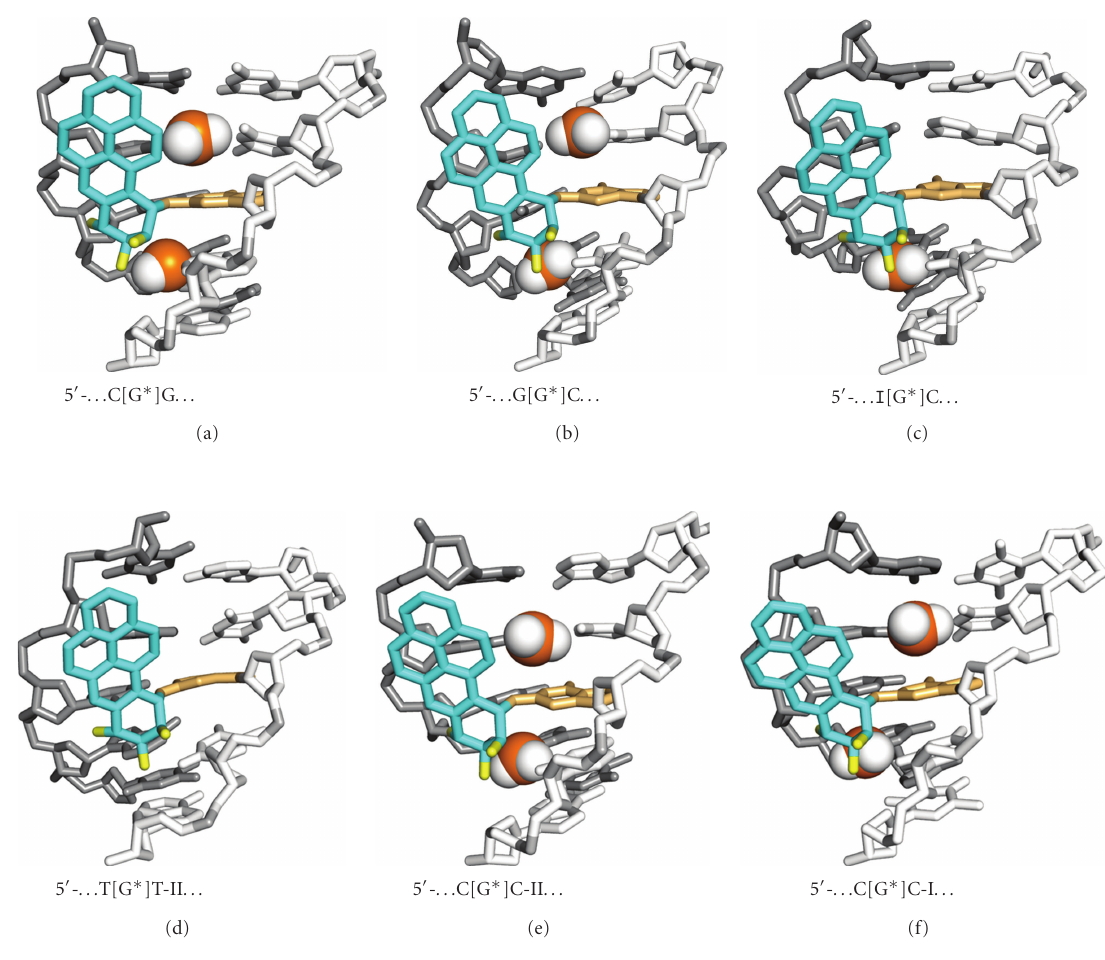
Figure 2: E ff ects of nearby guanine amino groups on the positioning of the 10 S (+)- trans - anti -B[ a ]P- N 2 -dG adduct in the minor groove of the lesion-containing duplexes. The presence or absence and exact location of the guanine amino groups is governed by the base sequence contexts and determines the structural distortion/destabilization of the damaged duplexes. The damaged strand is light grey, and the partner is dark